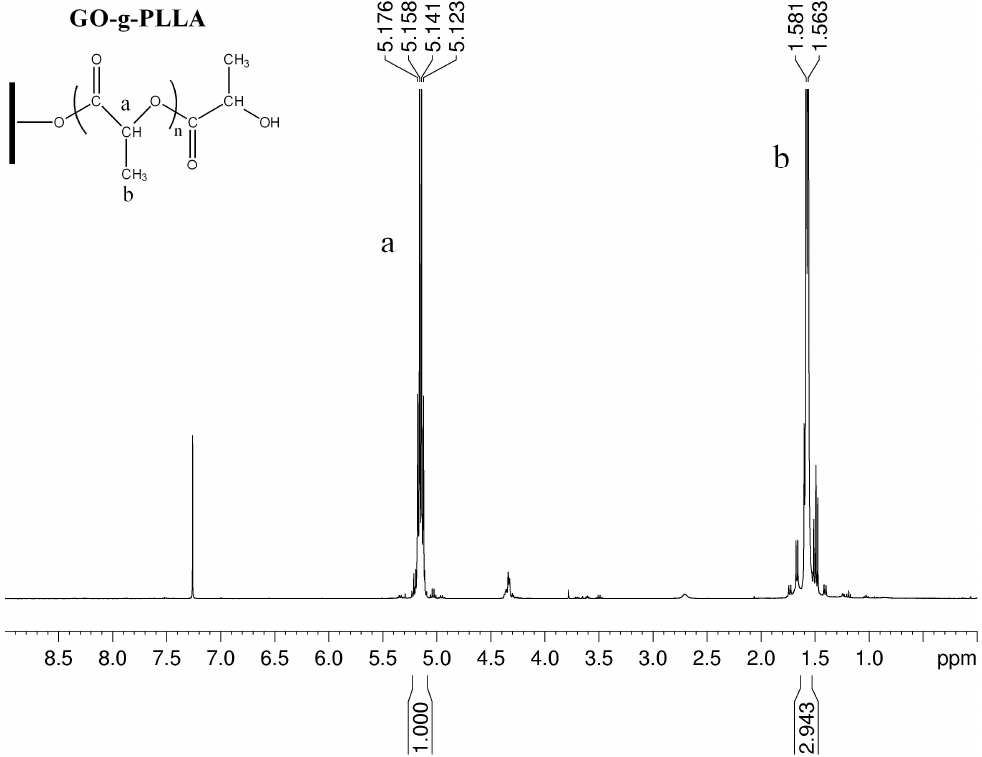
Figure 1. The 400 MHz 1 H nuclear magnetic resonance (NMR) spectrum of the GO-g-PLLA.